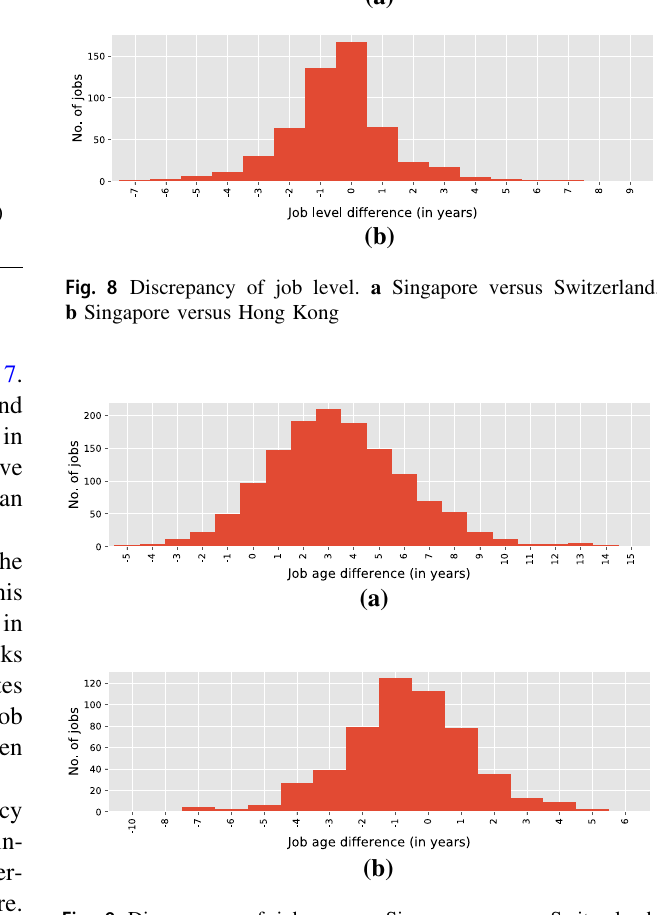
Fig. 9 Discrepancy of job age. a Singapore versus Switzerland. b Singapore versus Hong Kong